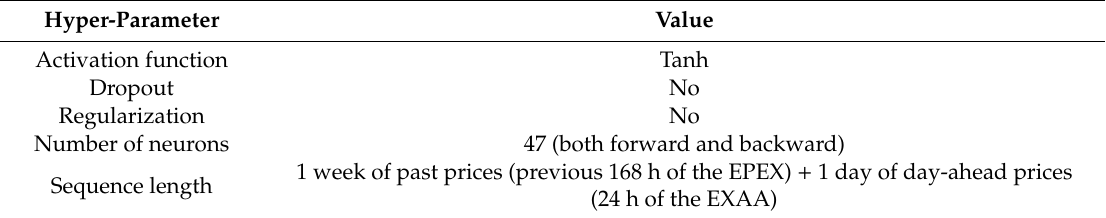
Table 2. Hyper-parameter settings in our proposed